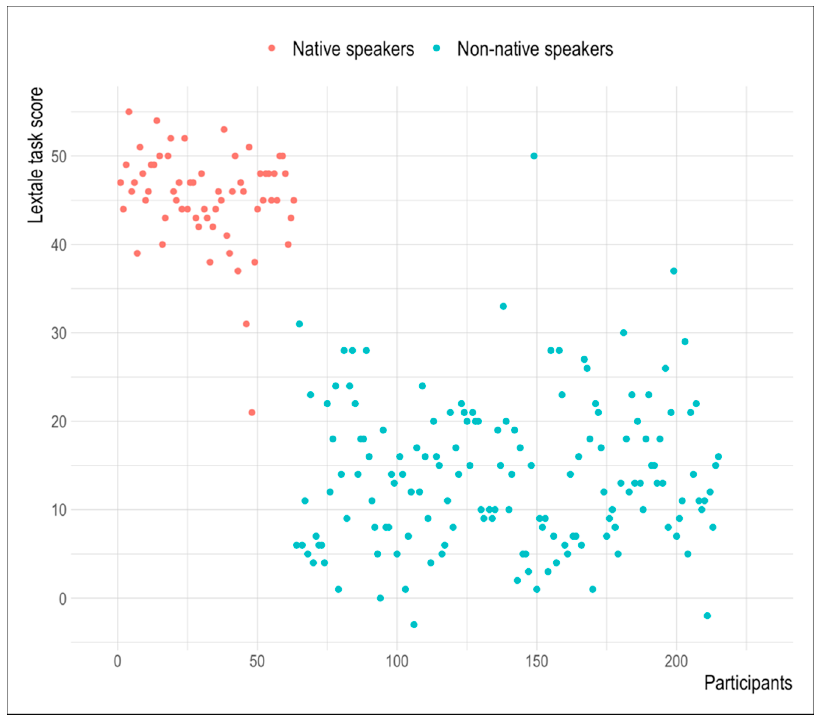
Figure 3. Score of the Lextale task per participants.